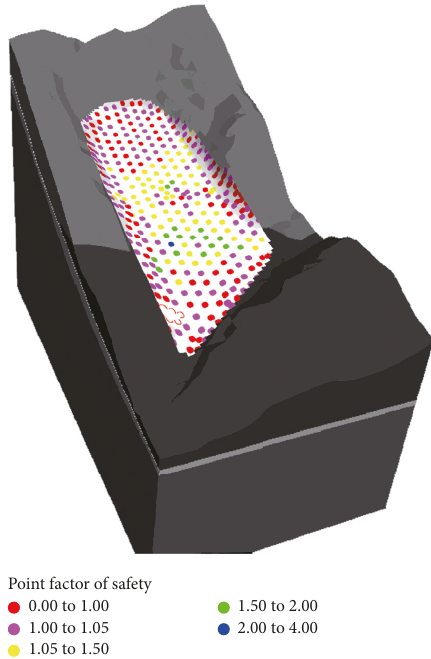
Figure 11: Point factor of safety after